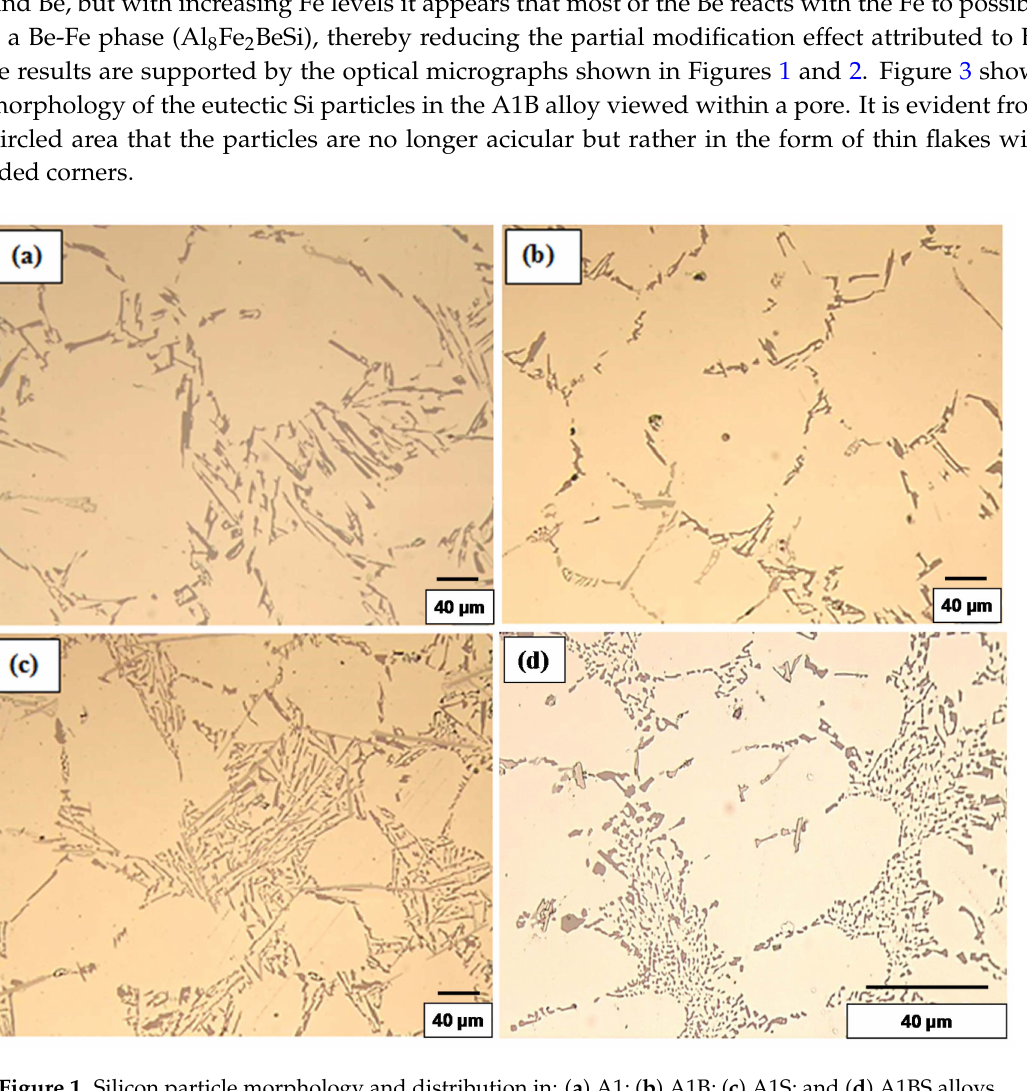
Figure 1. Silicon particle morphology and distribution in: ( a ) A1; ( b ) A1B; ( c ) A1S; and ( d ) A1BS alloys, DAS ~ 25 µ